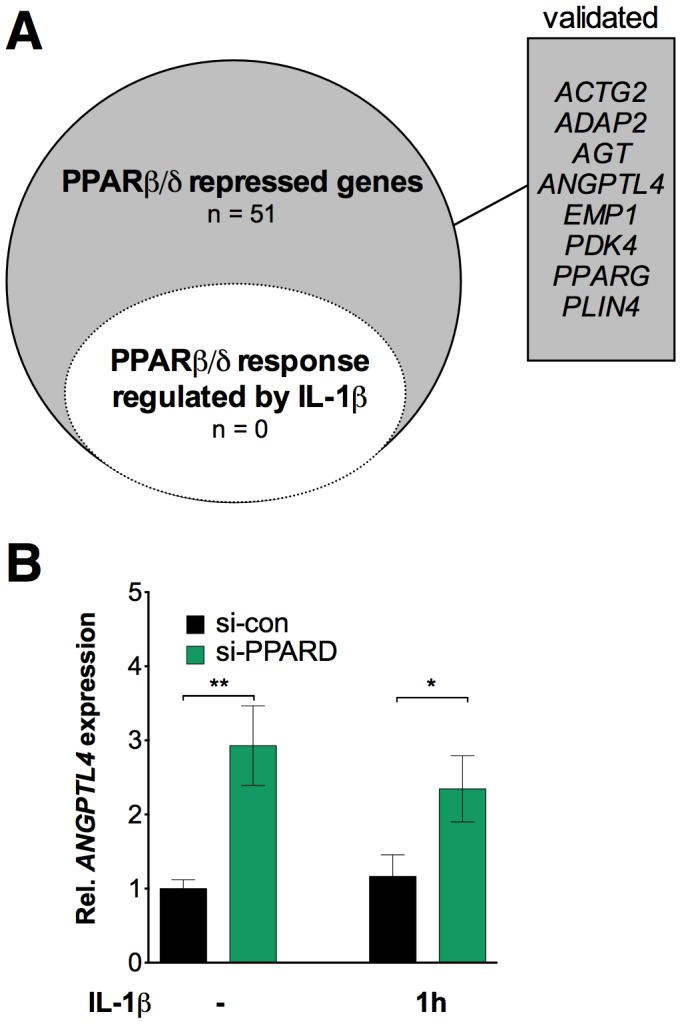
Effect of IL-1β on PPARβ/δ target genes.(A) Set (n = 51) of PPARβ/δ target genes (defined as genes upregulated by siRNA-mediated PPARβ/δ depletion) and empty subset of these genes affected by IL-1β (n = 0). HeLa cells were treated and analyzed as in Figure 1 (threshold ≥1.8-fold regulation; Dataset S3). Verified genes are listed in the boxed area and shown in Figure S4. (B) Effect of IL-1β on the PPARβ/δ response of the ANGPTL4 gene. Values represent averages ±SD (n = 3). ***, **, *significant difference between si-con and si-PPARD-treated cells (p<0.001, p<0.01, p<0.05 by t-test).